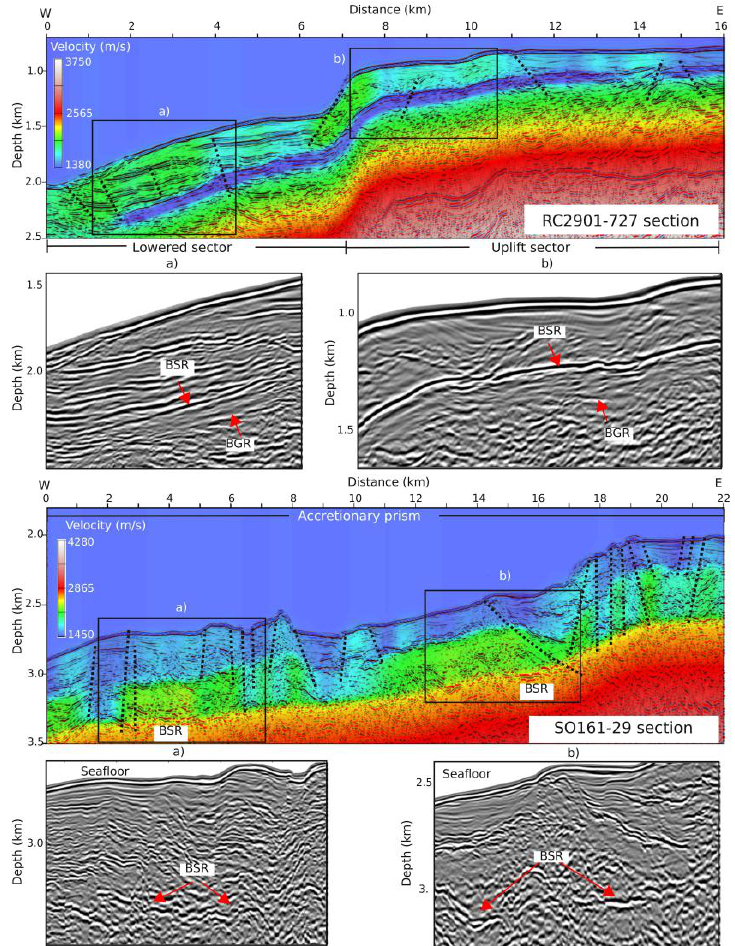
Figure 2. Velocity model superimposed to the Kirchhoff pre-stack depth migration (PreSDM) sections of the northern ( upper panel) and southern ( lower panel) sectors. The rectangles in the sections indicate the position of the zooms (a and b), in which the bottom simulating reflector (BSR) and the free gas reflector (BGR) (if present) are indicated by red arrows. Faults and fractures are indicated by dotted lines.